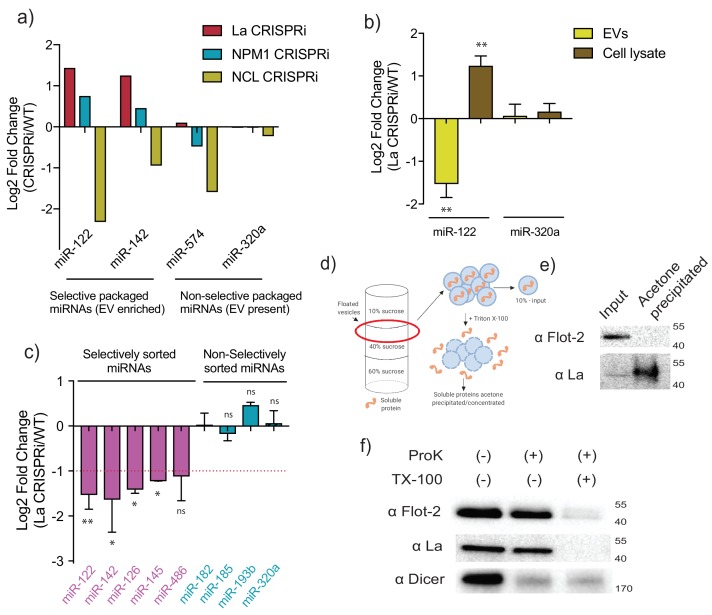
MiR-122 sorting into sEVs requires La in vivo.(a) Log2 fold change for intracellular levels of miRNAs of interest post-depletion of the shown RBPs by CRISPRi. MiR-122 and miR-142 were used as representatives of selectively packaged miRNAs. MiR-574 and miR-320a were used as representatives of non-selectively packaged miRNAs. Data quantified by RT-qPCR, normalized per ng of total RNA. (b) Log2 fold change of intracellular and secreted levels of miRNAs of interest quantified by RT-qPCR. sEVs were purified from WT and La-depleted cells. Cellular lysates were isolated at the moment of EV collection. MiR-320a was used as a control for non-selectively packaged miRNAs. Data plotted are from three independent experiments (biological replicates); each independent experiment with triplicate qPCR reactions, error bars represent standard deviation from independent samples. (c) Log2 fold change of secreted levels of miRNAs of interest quantified by RT-qPCR. sEVs were purified from WT and La-depleted cells. MiRNAs in pink represent miRNAs selectively sorted into vHD sEVs, miRNAs in blue represent non-selectively sorted miRNAs present in both vLD and vHD sEVs. Data plotted are from three independent experiments (biological replicates) for miR-122, miR-142 and miR-320a and from two independent experiments (biological replicates) for the rest; each independent experiment with triplicate qPCR reactions; error bars represent standard deviation from independent samples. (d) Schematic representation of the flotation assay and acetone precipitation as in (e). The high-speed pellet of conditioned medium was floated in a step sucrose gradient (input) and the soluble content was released by the addition of TX-100 and then concentrated by acetone precipitation (acetone precipitated). (e) sEV samples post-flotation and acetone precipitation/concentration were tested. Immunoblots for flotillin-2 and La are shown. Acetone precipitation captures mostly soluble proteins (Feist and Hummon, 2015), thus flotillin-2 is only detectable in the floated sample, prior to acetone precipitation, whereas La detection improves post precipitation/concentration. (f) Proteinase K protection assays in high-speed pellet fractions. Samples were treated with or without proteinase K and or Triton X-100. Immunoblots for flotillin-2, La and Dicer are shown. Statistical significance was performed using Student’s t-test (*p<0.05, **p<0.01, ns = not significant).